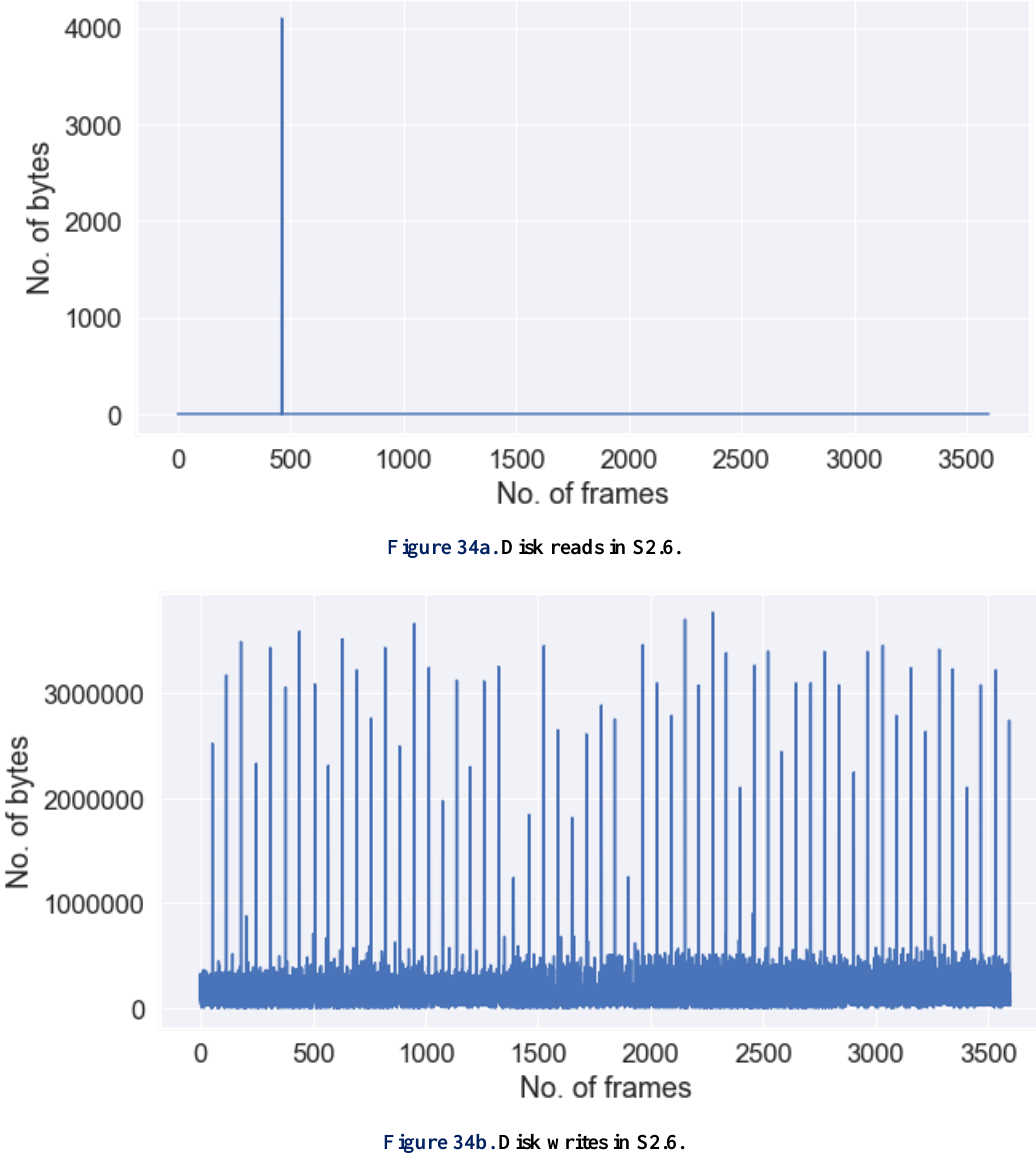
Figure 34b. Disk writes in S2.6.